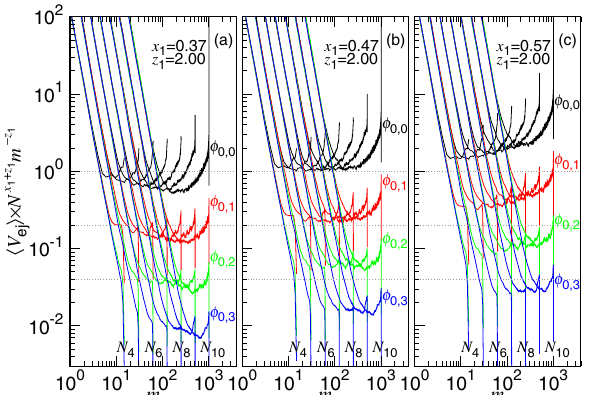
Figure 4. Rescaled speed The exponent z 1 is assumed 2.0. The chain length N i curve. The initial volume fraction is indicated on the right side of the set of the curves sharing the same φ 0 value, calculated by the formula φ 0, j